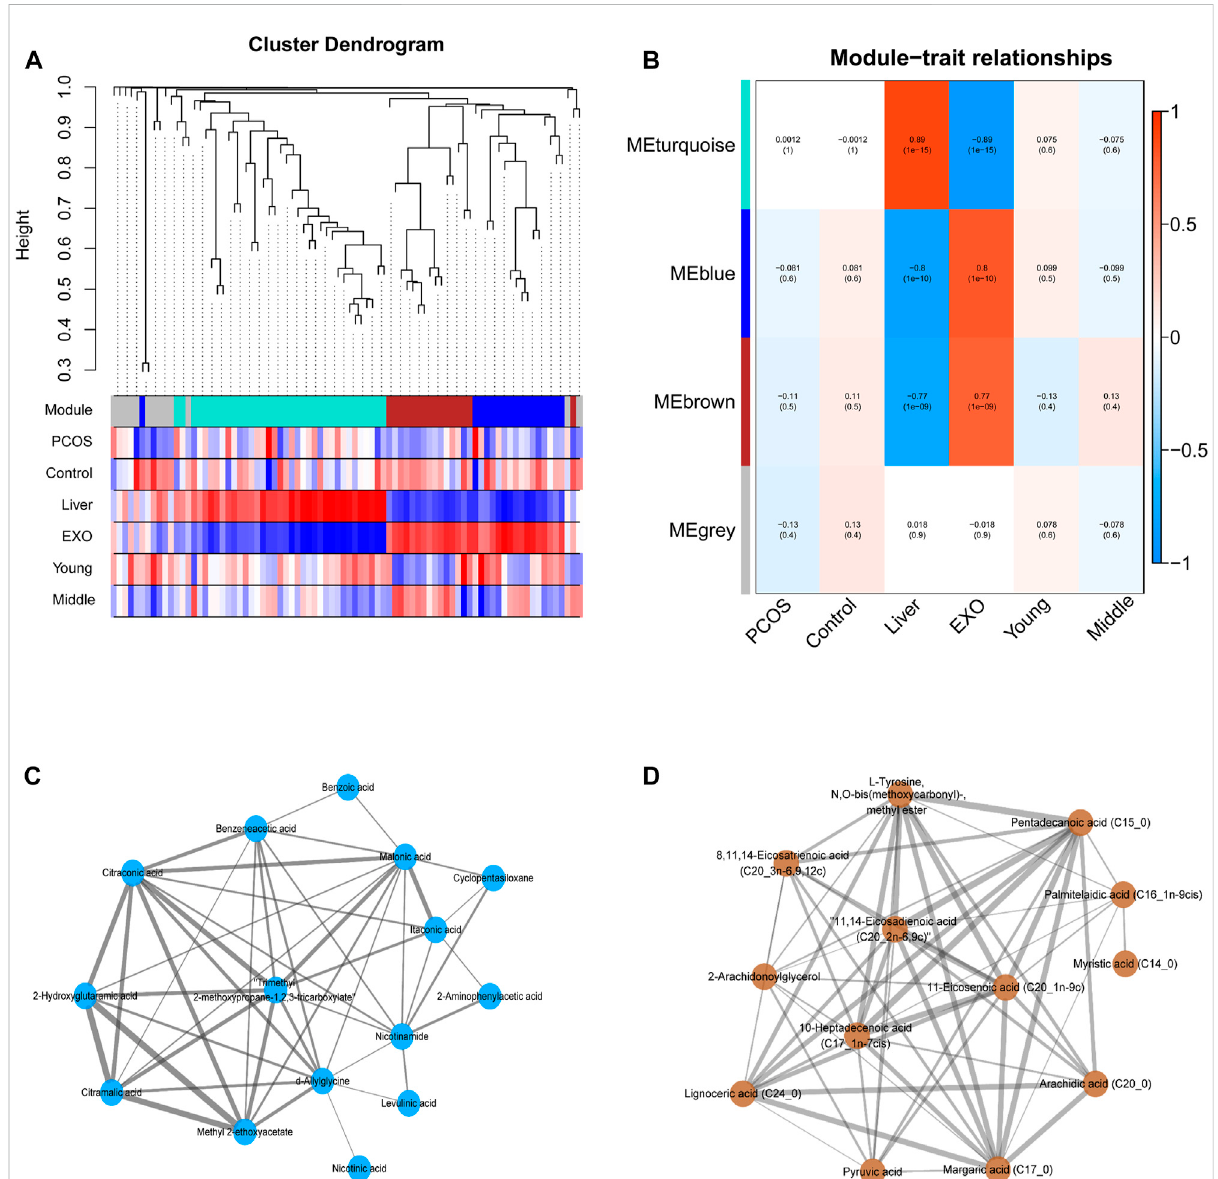
FIGURE 5 (A) The cluster dendrogram of co-expression network modules ordered by WGCNA based on the topological overlap matrix (TOM), each module was assigned different colors. (B) Heatmap of Module-trait relationships. Each row corresponds to a module eigengene (ME), and the columncorrespondstoatrait.Eachcellcontainsthecorrespondingcorrelationandp-value. (C – D)